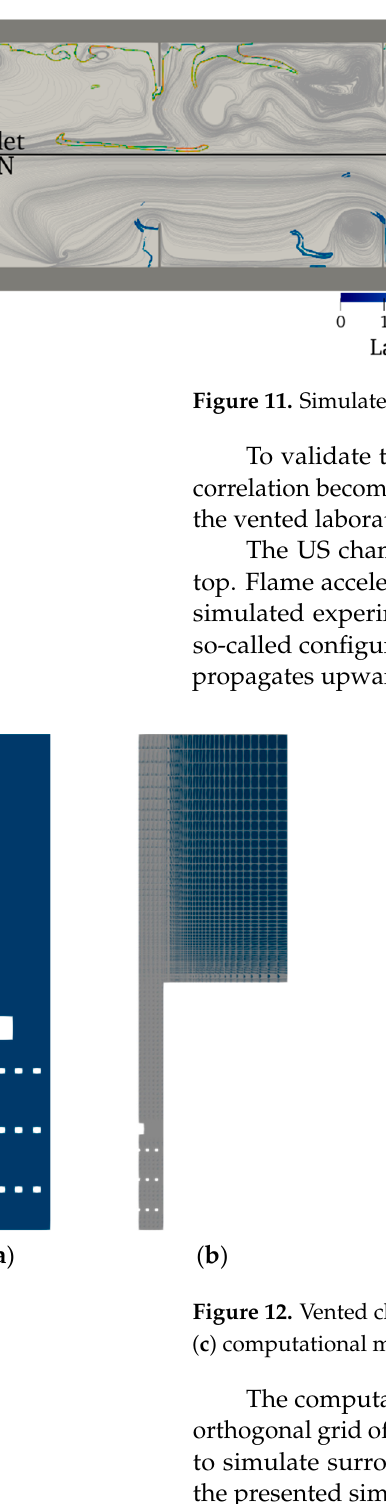
13 of 18 Figure 10. Pressure evolution at 6.227 m height of ENACCEF2. Figure 11 presents flow streamlines and laminar burning velocity values calculated in both cases when the flame is in a similar location. Only values on the flame brush (pro- gress variable source term larger than 1000 1/s) are shown. There is a clear difference in the laminar flame velocity values obtained with both methods. The influence of pressure and temperature are far more pronounced in the Malet correlation case, where the burnt- mixture side of the flame brush exhibits two to three times higher velocity values than the